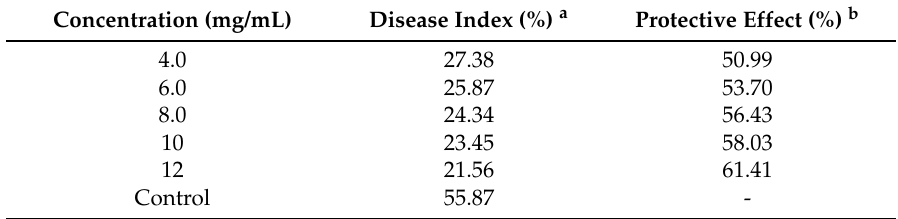
Table 8. Screening the protective effect of BAEO against Blumeria graminis.